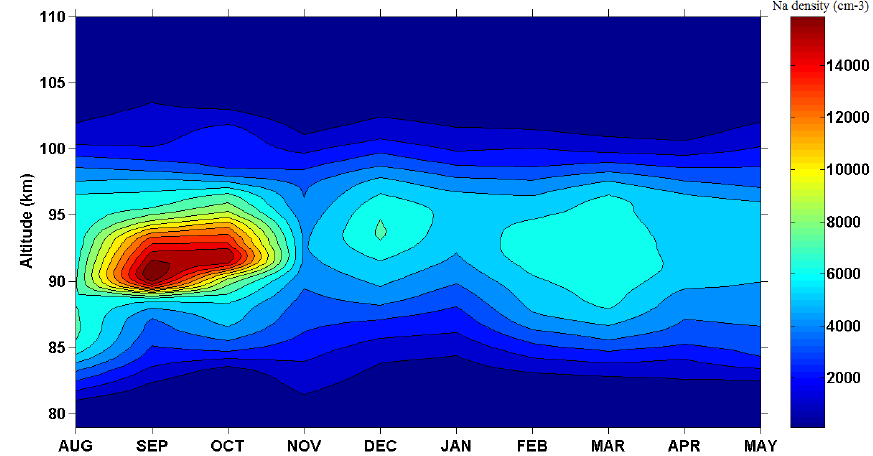
Fig. 6. Height-month contour plot of average seasonal variation of sodium density (cm − 3 ) obtained from lidar observations in 2005–2006 over